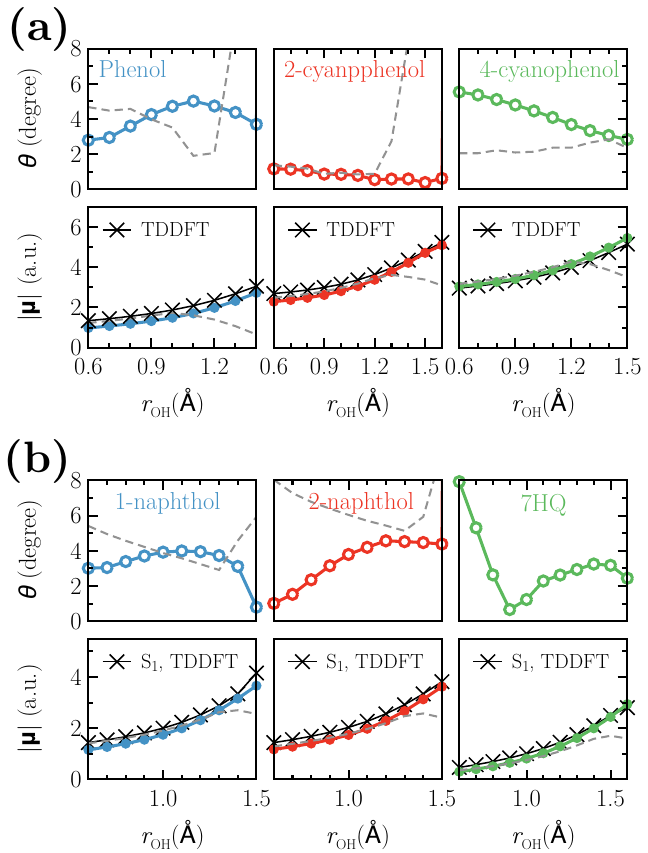
Figure 4. Dipole moments of ( a ) phenol- and ( b ) naphthol-based photoacids. The lower panels show the length of the dipole moment vector, while the upper panels present the angle between the dipole moment vectors calculated at T 1 state together with the optimized effective potentials and the ones computed at S 1 state for the same systems using TDDFT. The black crosses in the lower panels denote the reference TDDFT values. Gray dashed curves represent the values obtained at T 1 state without any additional